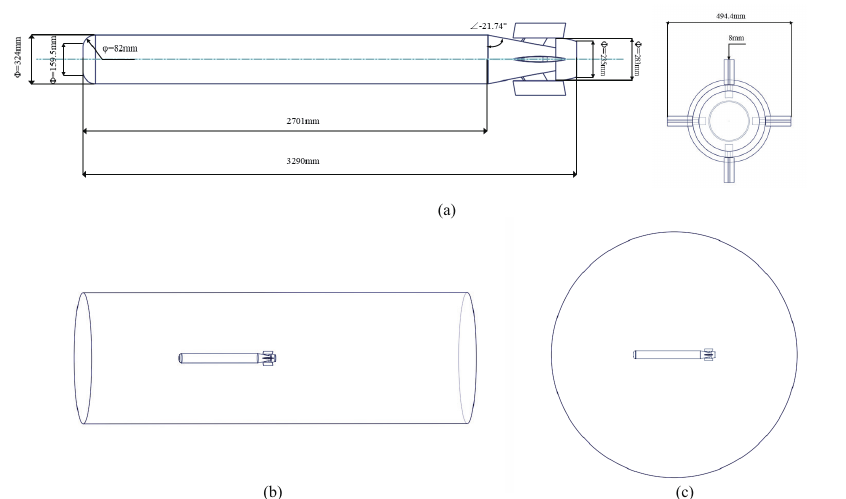
Figure 1. Diagram of the model. ( a ) Underwater vehicle model ( b ) Flow field calculation domain ( c ) Acoustic computational domain.